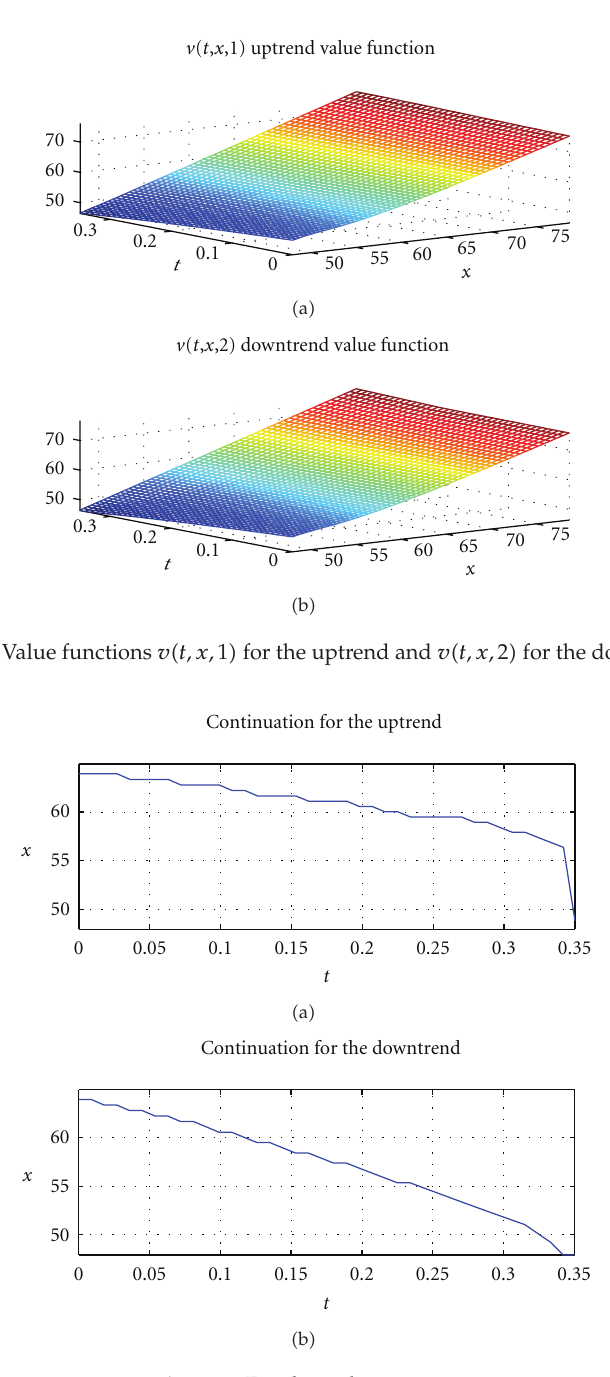
Figure 2: Free boundary